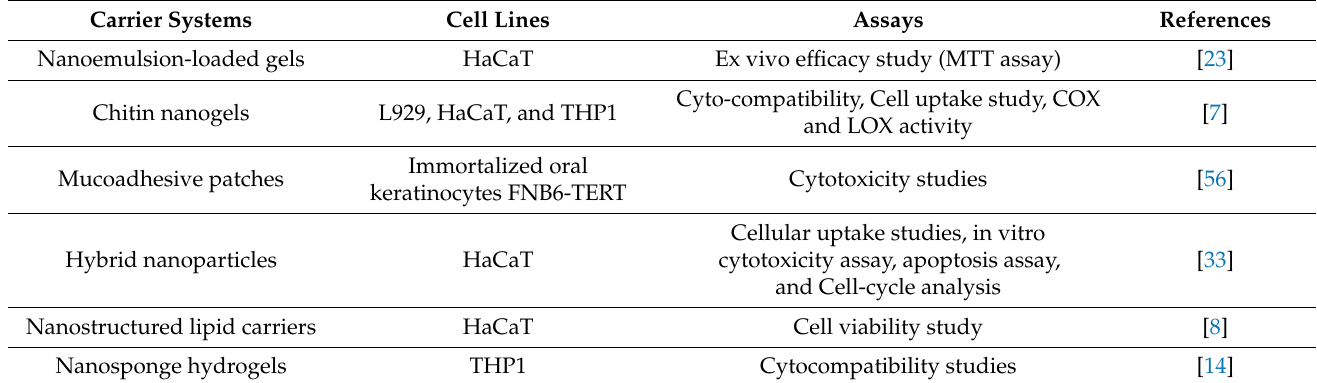
Table 2. Cell line reports for novel formulations of clobetasol